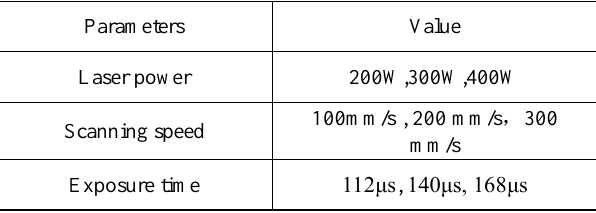
Table 1. Parameters of selective laser melting